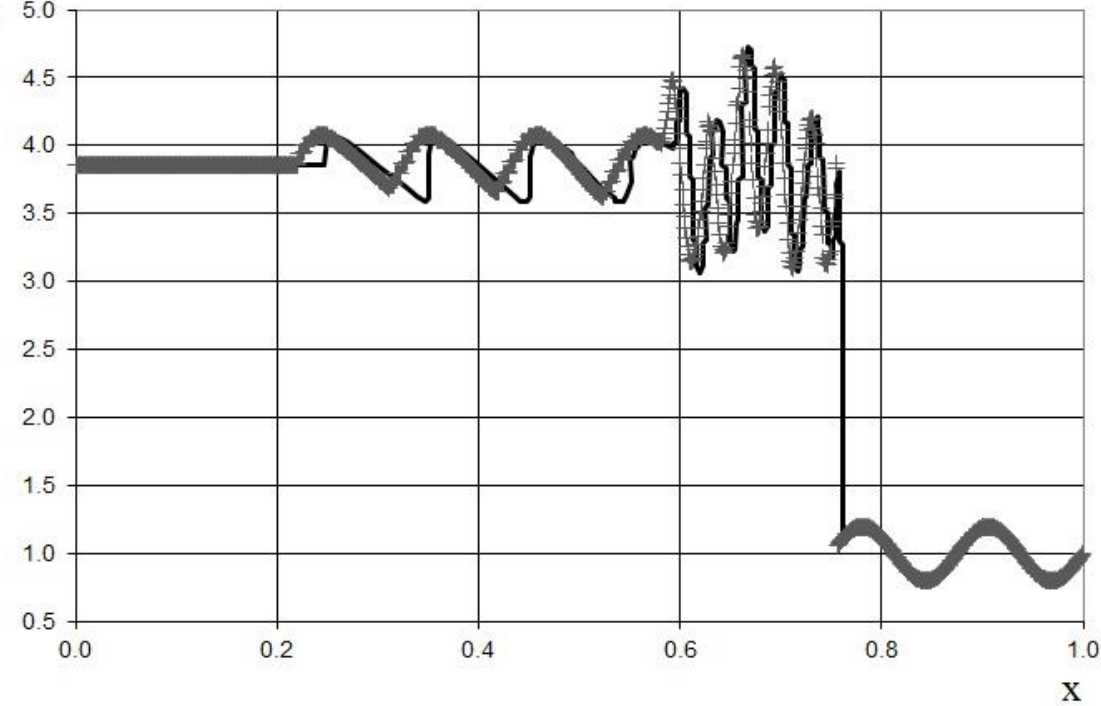
Figure 25. Density plot for the Shu–Osher shock-tube problem, using the finer grid (1000 grid points): the “exact” solution [44] (line), and the present method (cross).